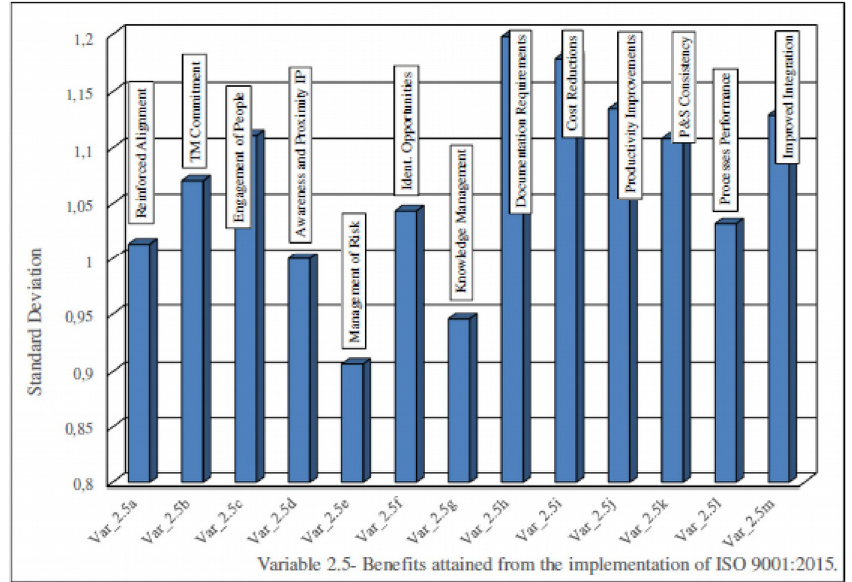
Figure 4. Standard deviations of the benefits attained by the